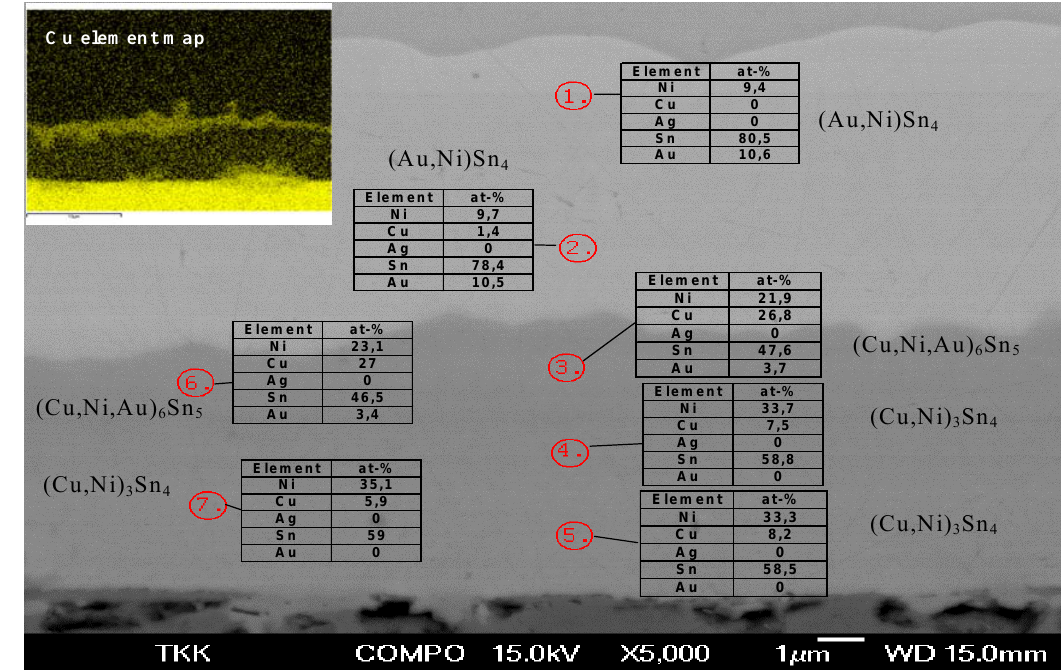
Figure 19. SEM micrograph together with point analyses and Cu element map from the (SnAg)/Ni/Au system after annealing for 2,000 hours at 150